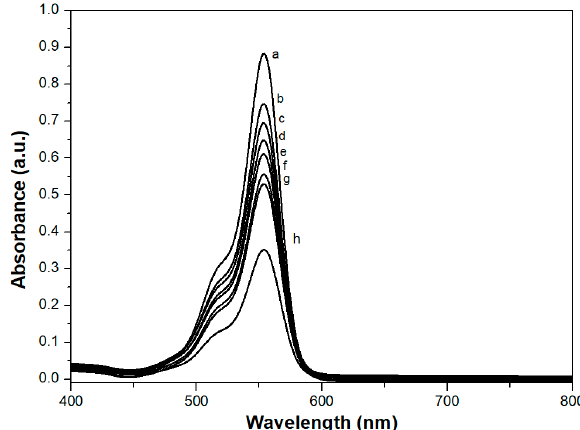
Figure 5. UV-Vis spectra, showing the intensity decrease of the maximum characteristic peak at 553 nm of 1.5 × 10 − 2 mM Rhodamine B in water solution ( a ), after 1 ( b ), 2 ( c ), 3 ( d ), 4 ( e ), 5 ( f ), 6 ( g ) and 24 ( h ) hours of contact with the calcined Mono-ICE, at room temperature.